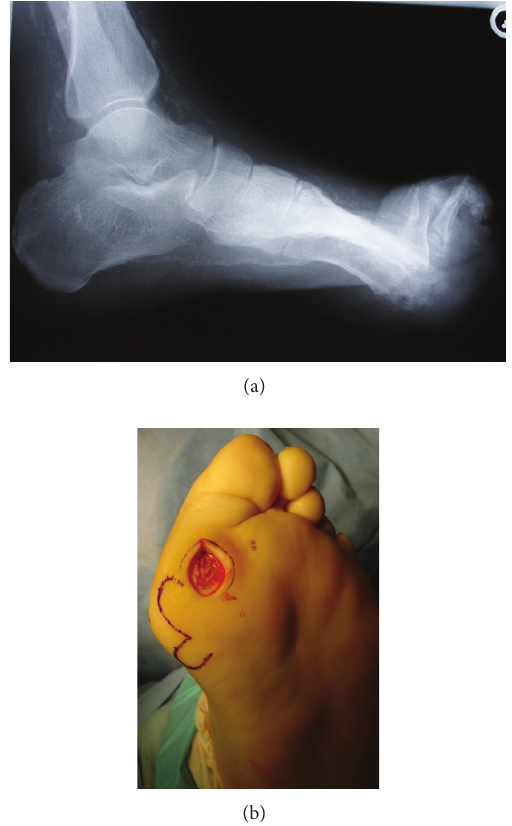
F 4: Abnormal biomechanics contributing to pressure ulcer at �rst metatarsophalngeal joint. (a) �-ray image showing foot deformity. (b) Photograph of foot illustrating bony abnormalities and